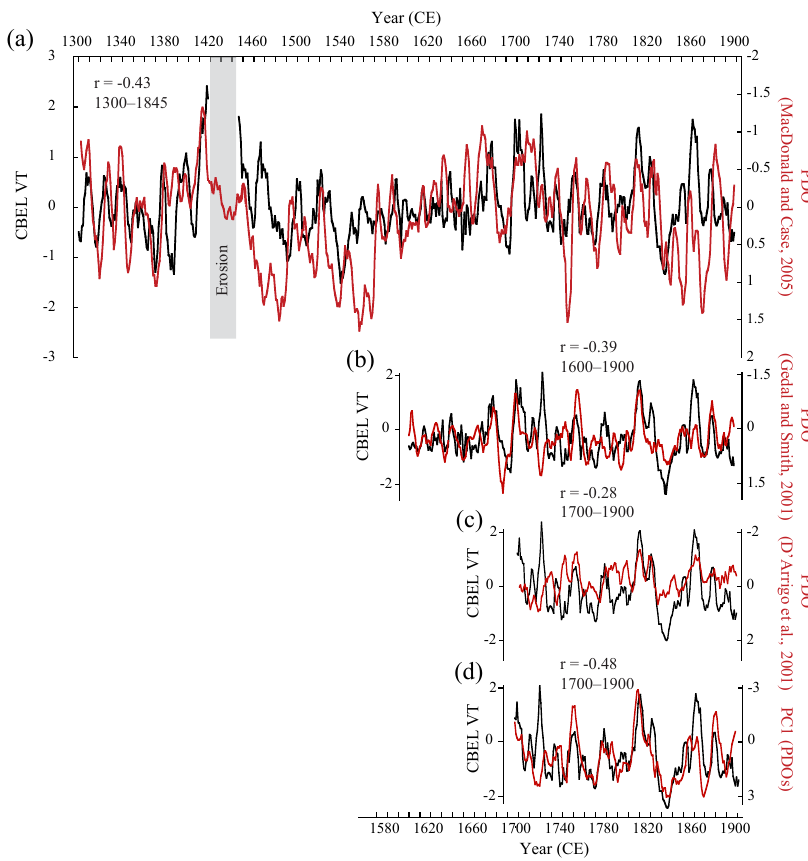
Figure 4. (a) Comparison between normalized Cape Bounty East Lake varve thickness and normalized PDO from MacDonald and Case (2005) (VT is shifted 18 years earlier). (b) Same as (a) but for the PDO from Gedalof and Smith (2001). (c) Same as (a) and (b) but using the PDO from D’Arrigo et al. (2001). (d) Same as (a) , (b) and (c) but using the PC1 extracted from PCA analysis of the three PDOs. Time series are filtered by a 5-year running